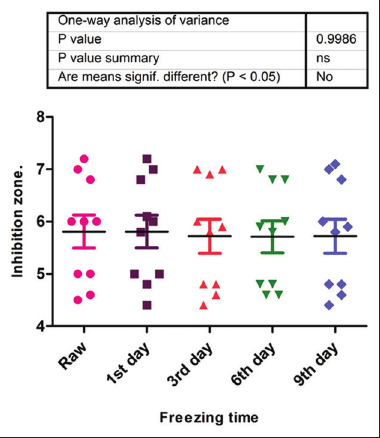
Figure-1: Effect of freezing on the concentration of oxytetracycline